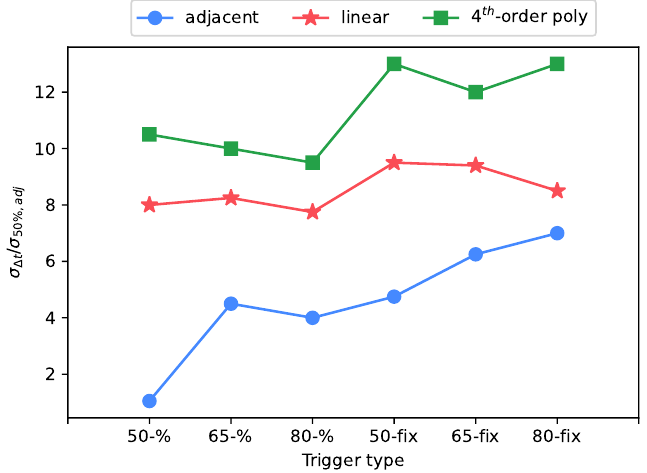
Figure 7. Standard deviation of arrival time shift: test case at 8.1 µ s rise time, 1.5 V of full scale level.